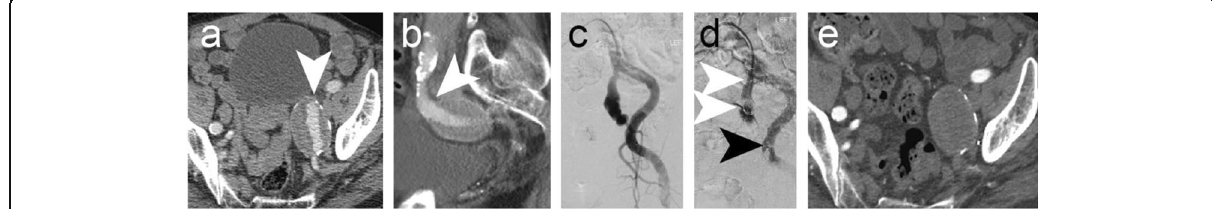
Fig. 6 Case 6. Preprocedural CTA showing a left IIA aneurysm - axial ( a ) and sagittal ( b ) sections. c Pre-embolisation DSA imaging. d Microcoils were used for vessel embolisation distal to the aneurysm sac (black arrow). A 12 mm diameter shape memory polymer plug was deployed into